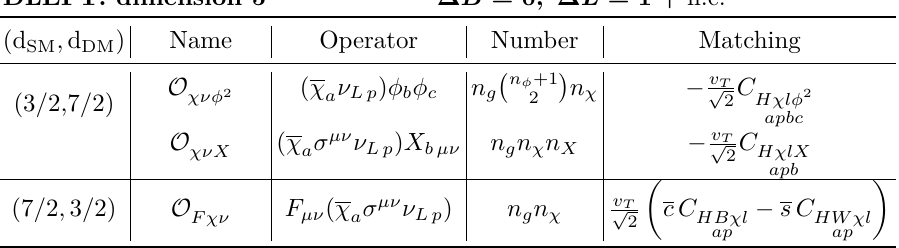
Table 26 . Dimension-five ∆ B = 0 , ∆ L = 1 operators in DLEFT. The first column gives the dimensions of the SM and DM part of the operator, the fourth column is the number of operators, and the fifth column is the additional matching contribution at the EW scale.